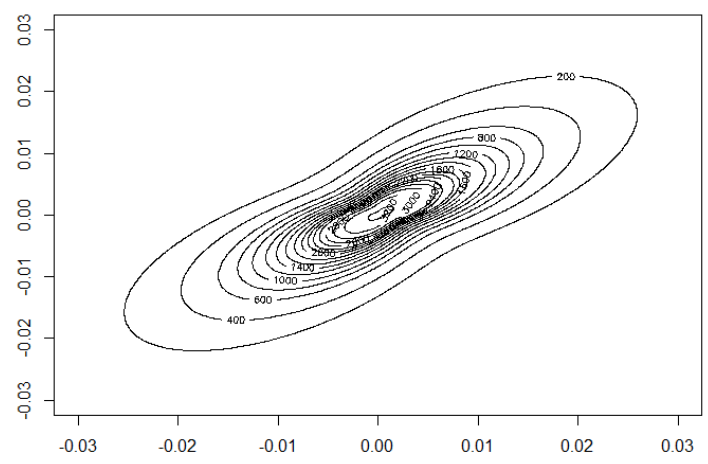
Figure 13. Contour plot of the estimated density.